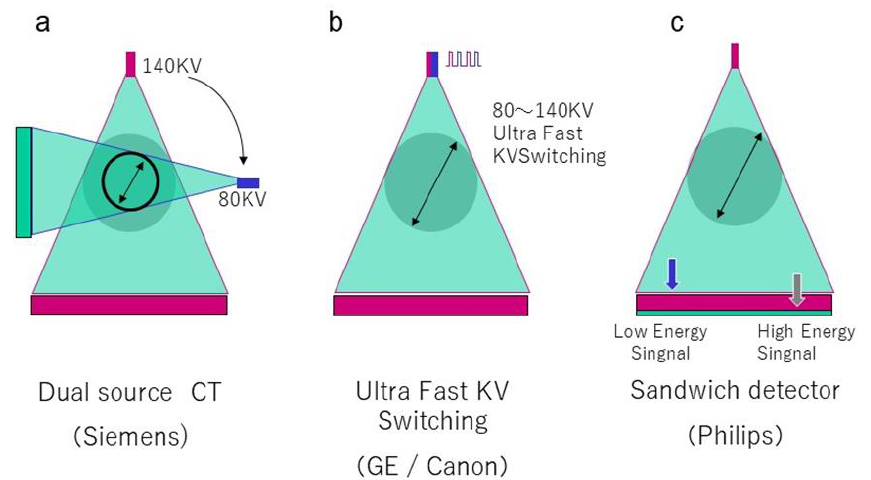
Figure 1. Imaging Method of Dual-Energy Computed Tomography (CT). This is a schematic showing ( a ) a dual-source CT in which X-rays of different tube voltages are simultaneously irradiated from two bulbs with 90 ◦ orientation differences, ( b ) a single-source CT system in which the tube voltage is switched to a fast switching mode (Fast kV switching) of 0.5 ms or less, and ( c ) a single-tube voltage X-ray irradiated with a stacked detector.